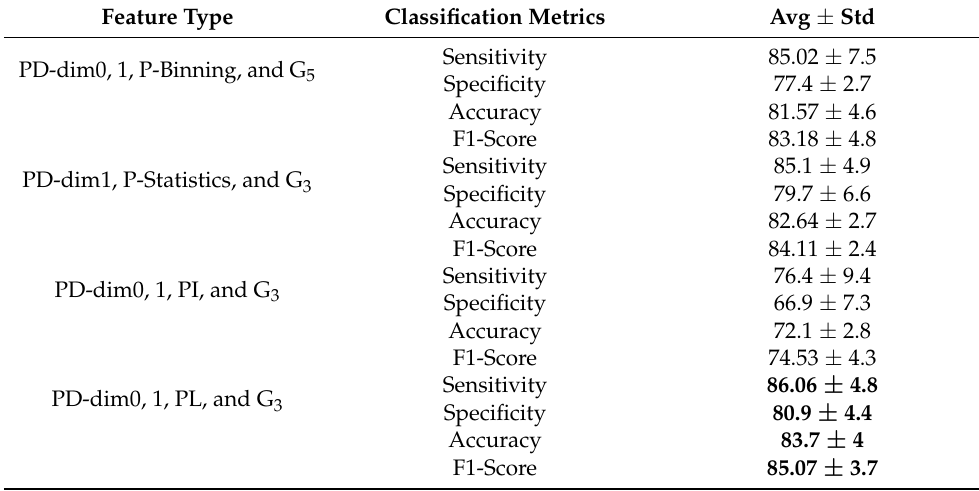
Table 1. The top performing ULBP geometries and PH dimension and all PD vectorizations for DDSM. Avg = average, Std = standard deviation for 5-fold cross-validation using